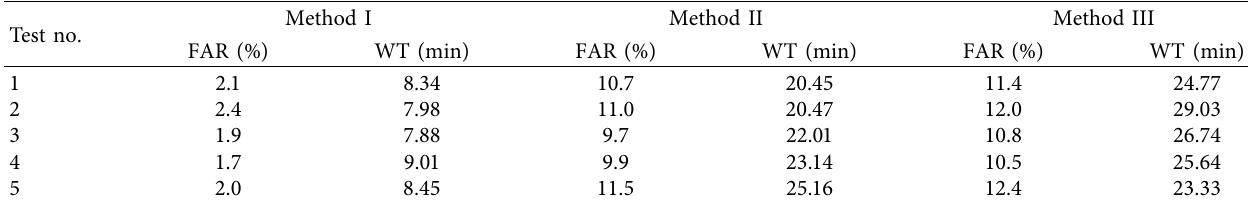
Table 2: Comparison of FAR and WT among methods I, II, and III. Test